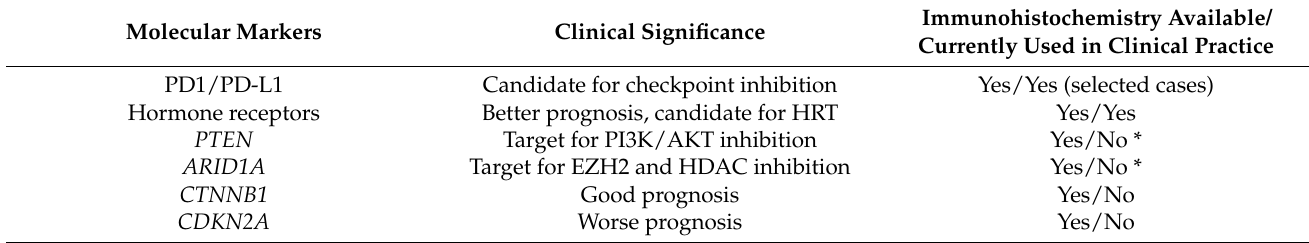
Table 4. Other molecular markers associated with endometrioid ovarian carcinomas.